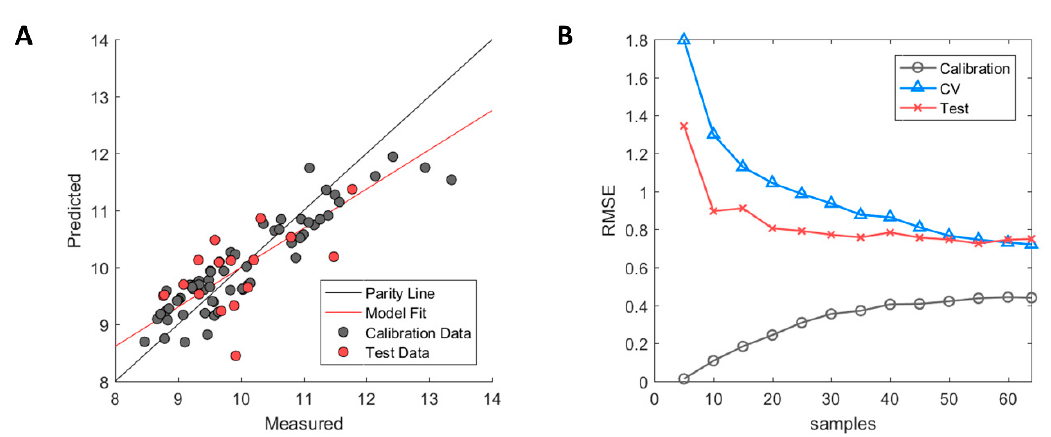
Figure 1. Performance diagnostics of Seq2D based model. ( A ) Measured versus predicted values of calibration (grey) and test set (red) samples. ( B ) Model learning curve showing the change of root mean square error (RMSE) for calibration (grey circle), cross-validation (blue triangle) and test set (red cross). Optimised ϵ -SVM model parameters from the original calibration model were used.